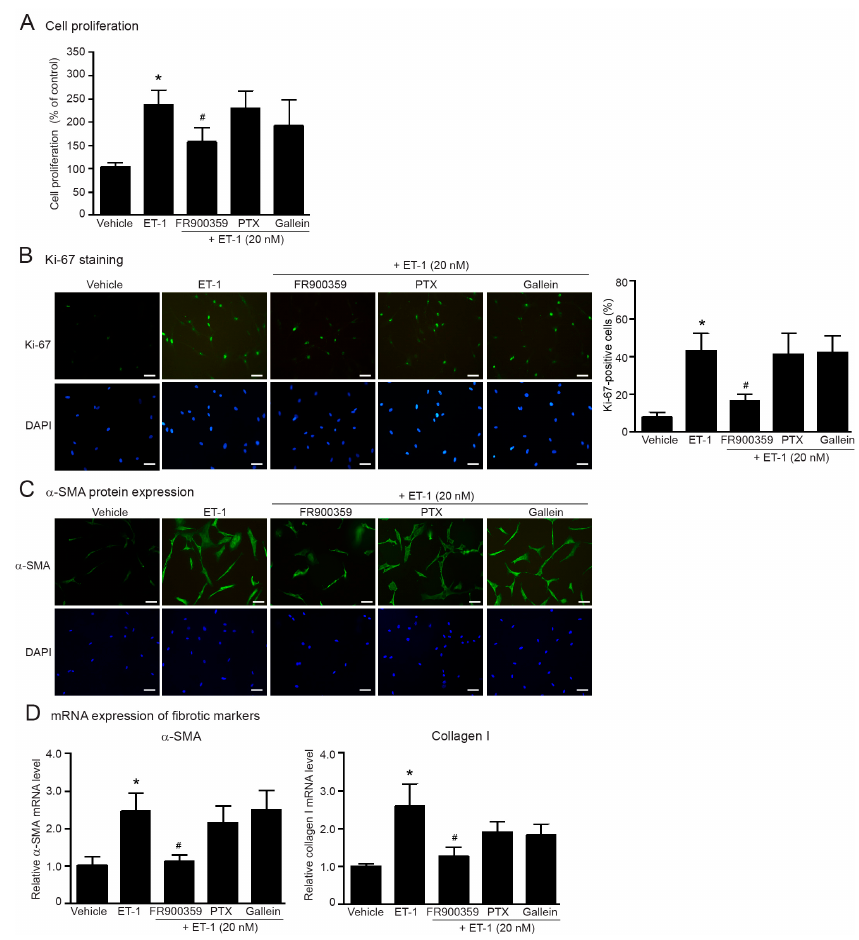
Figure 3. ET-1-induced cell proliferation and synthesis of α -SMA and collagen I is mediated through ET A R/G α q signaling. Cells were pretreated without or with FR900359 (G q inhibitor; 5 µM), PTX (G i/o inhibitor; 10 µM) or gallein (G βγ inhibitor; 10 µM) for 1 h before treatment with 20 nM ET-1 for 24 h ( A – C ) or 12 h ( D ). ( A ) Cell proliferation was calculated as the percentage relative to control group. ( B ) Cells were stained for Ki-67 (green) and nucleus DAPI (blue). Scale bar, 10 µm. Proliferative capacity was calculated as the percentage of Ki-67-positive cells. ( C ) α -SMA protein expression was visualized by fluorescent microscope. Cells were stained for α -SMA (green) and nucleus DAPI (blue). Scale bar, 10 µm. ( D ) Relative α -SMA and collagen I mRNA levels determined by RT-qPCR were calculated as the fold over the vehicle-treated group. Data were expressed as the mean ± SD. ( n = 4). * p < 0.05 vs. vehicle; # p < 0.05 vs. ET-1.